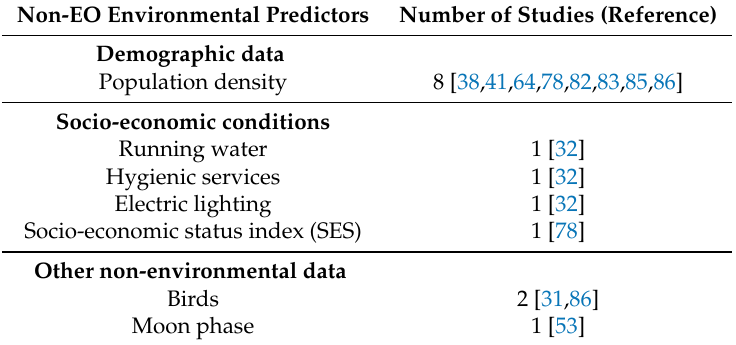
Table 1. Overview of studies that utilized Non- EO Environmental